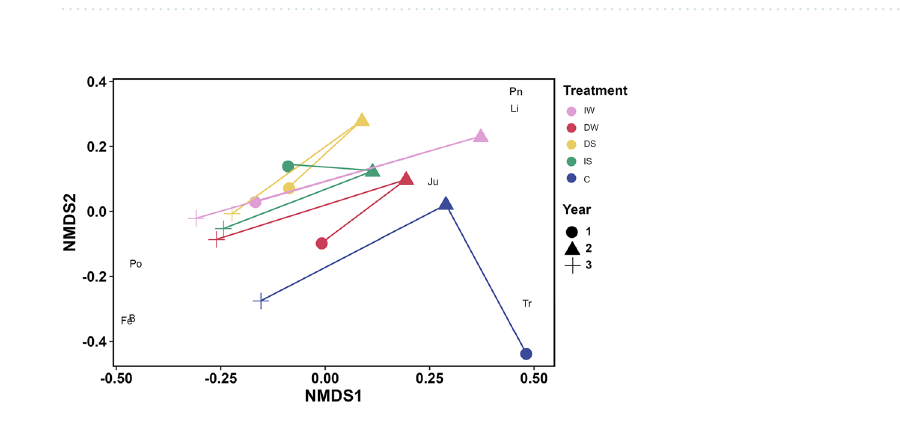
Figure 6. Non-metric multi-dimensional scaling (NMDS) plot of Lower Shore plant community composition (averaged % cover from August; n = 3) based on Bray–Curtis dissimilarity matrix. M moss; Fe Festuca rubra , Bl Blysmus rufus , Ca Carex nigra . Pink: increased water level (IW); red: decreased water level (DW); yellow: decreased salinity (DS); green: increased salinity (IS); blue: control (C). Circle: year 1 (2018); triangle: year 2 (2019); cross: year 3 (2020).